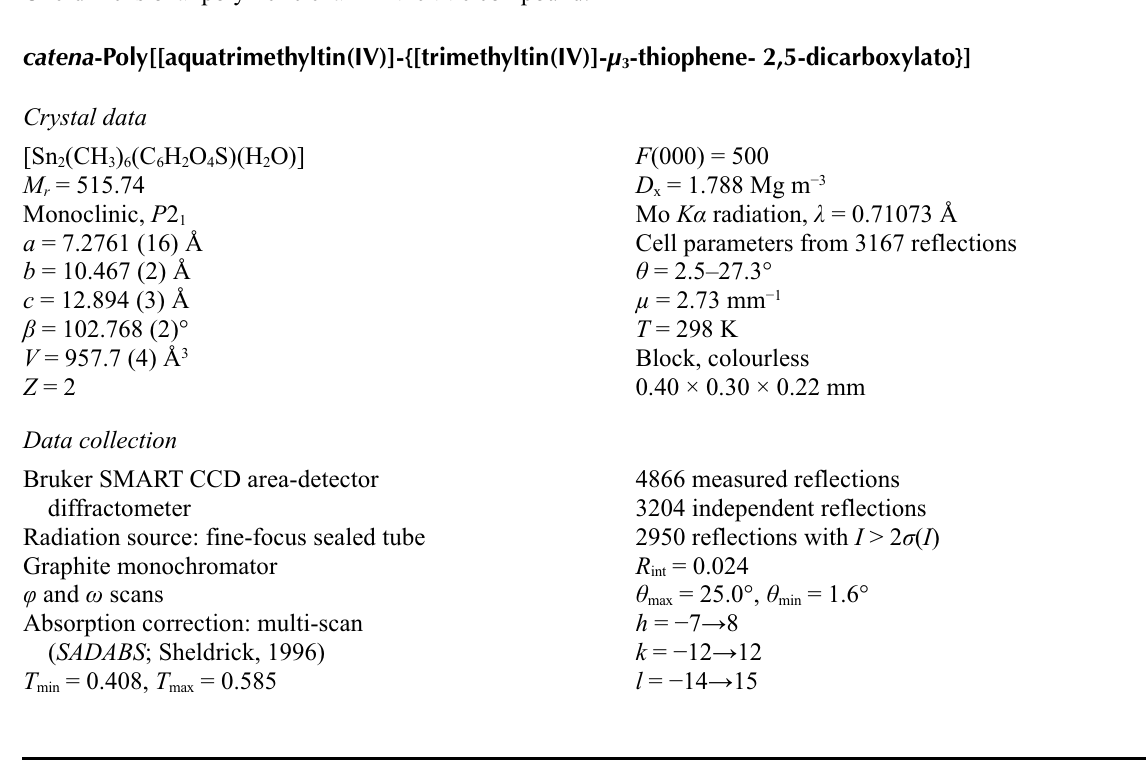
One-dimensional polymeric chain in the title